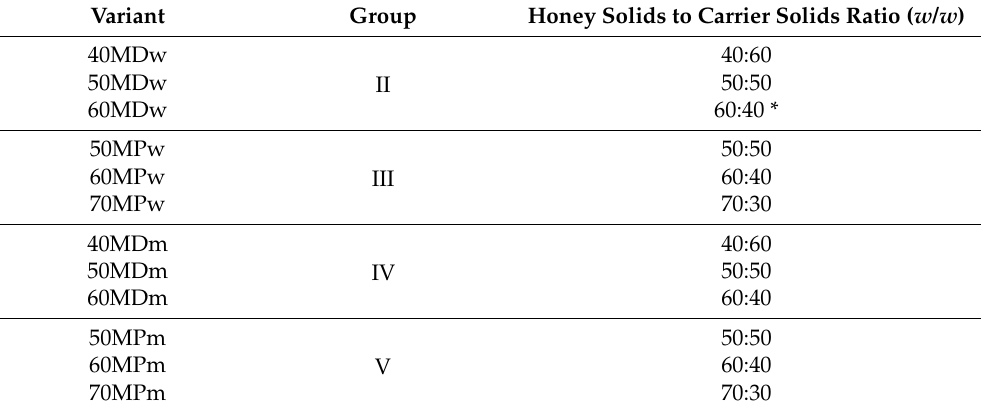
Table 1. Composition of honey powders obtained with different carriers (MD—maltodextrin, —milk powder) and diluents (w—water, m—skim